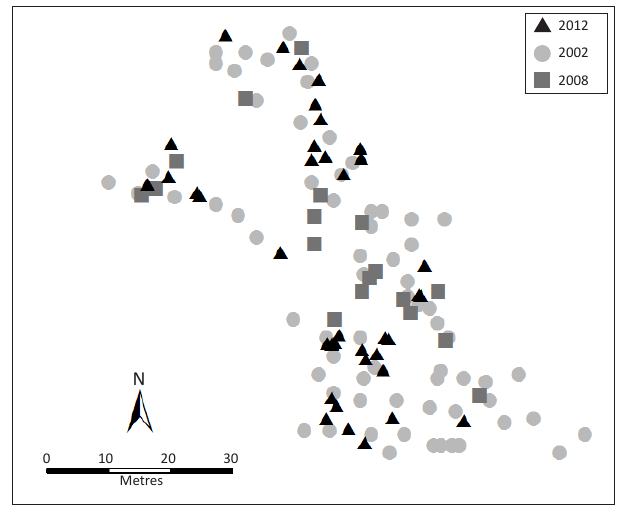
FIGURE 4: Distribution of host plants with eggs at the Nkandla monitoring site, as recorded during monitoring in 2002, 2008 and 2012, to illustrate changes in the distribution of